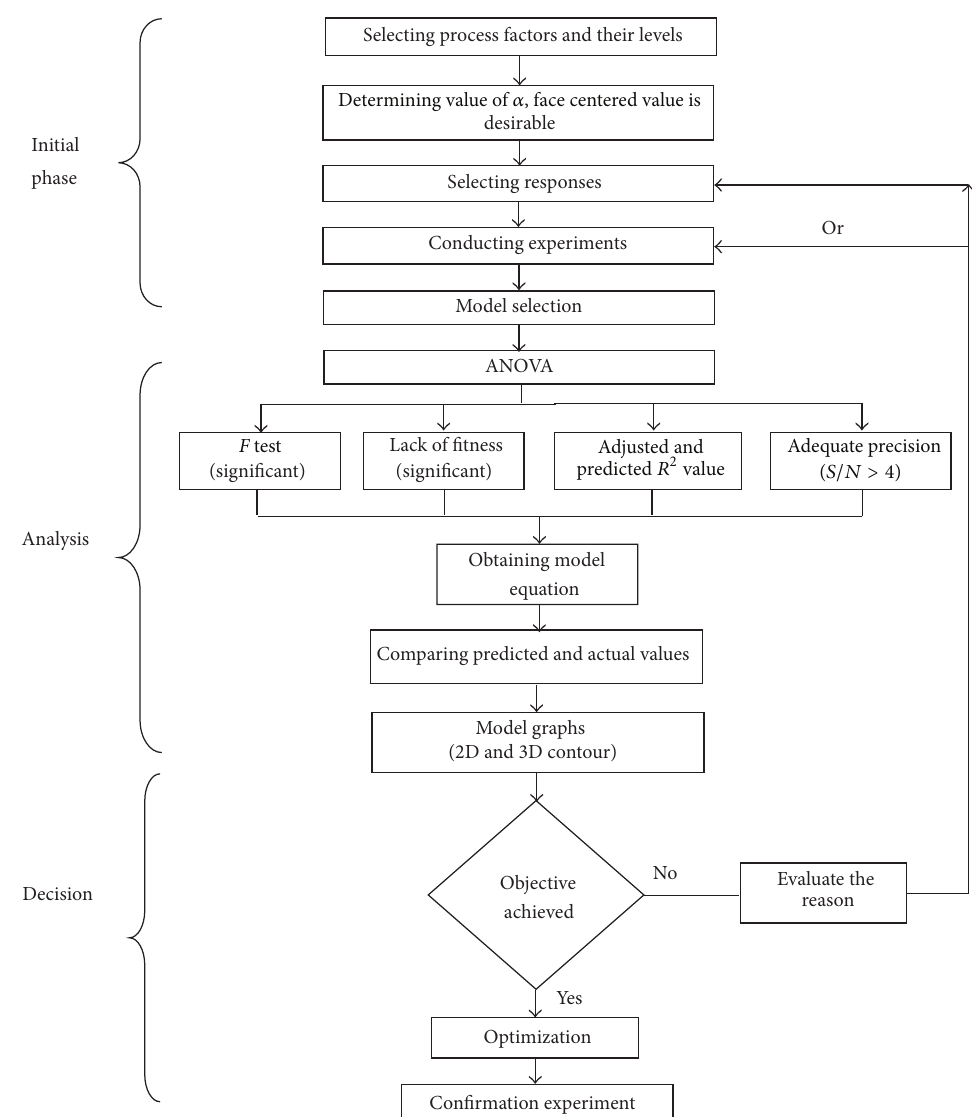
Figure 2: Central composite design flow